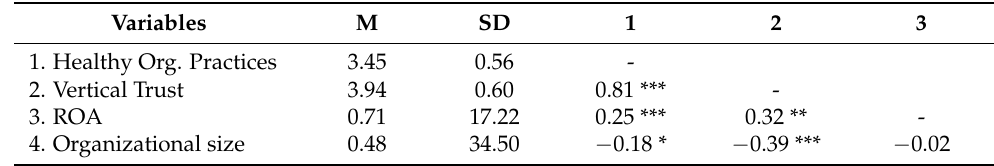
Table 3. Means, standard deviations, and intercorrelations among the study variables at the organi- zational level (N =